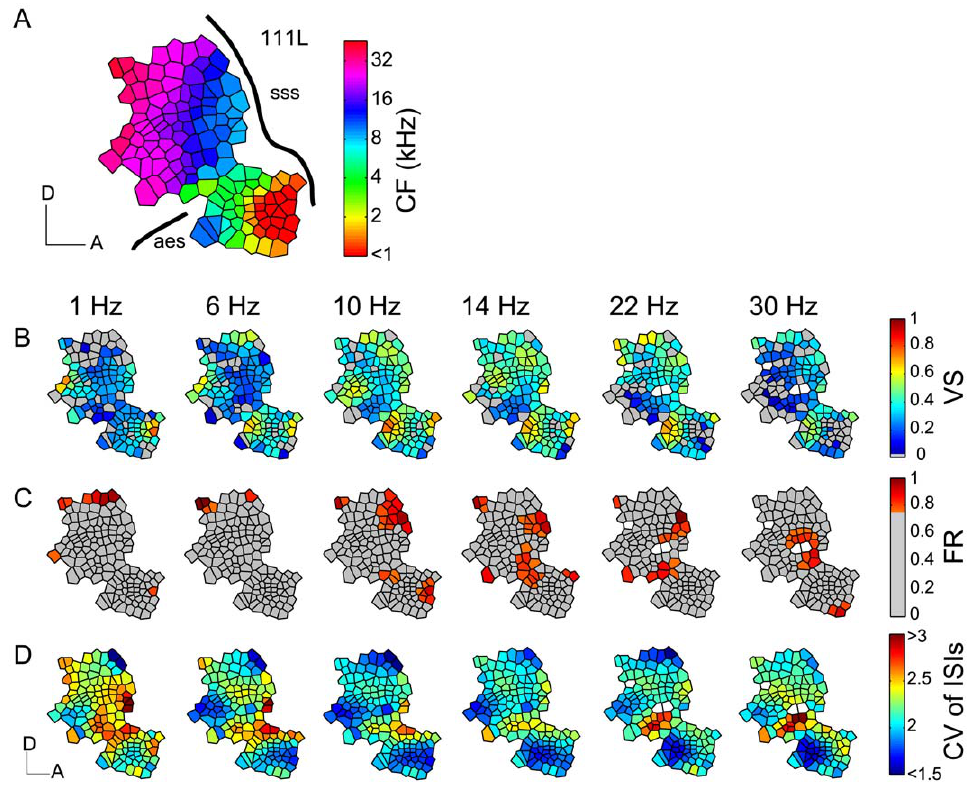
Figure 4. Spatial distribution of population response to different repetition rates. (A) Tonotopic gradient smoothed by a weighted least- squares linear regression model is reconstructed on the cortical surface by Voronoi-Dirichlet tessellation. An approximate location of AAF is indicated by the suprasylvian sulcus (sss) and the anterior ectosylvian sulcus (aes; thick black lines). Hemisphere 111L; D: dorsal, A: anterior, scale bars: 1 mm. (B) Spatial representation of VS as a function of different repetition rate. Repetition rates are shown on the top. White polygons indicate sites not tested for the corresponding repetition rates, which also apply to (C, D). Raw VS values of the Voronoi-Dirichlet tessellation maps were smoothed by a weighted least-squares linear regression model. (C) Spatial distribution of FR as a function of repetition rate. FR magnitude was normalized to the peak rate for the corresponding repetition rate. Normalized FR magnitudes were smoothed by a weighted least-squares linear regression model. High activity sites with FR . 0.75 in the smoothed maps were categorized and shown in the bottom panel as red polygons. Sites with FR , 0.75 are illustrated by gray polygons. (D) Spatial distribution of CV of ISI as a function of repetition rate. Spatially smoothed maps are shown. D: dorsal, A: anterior, scale bars: 1 mm. The scales also apply to (B, C).